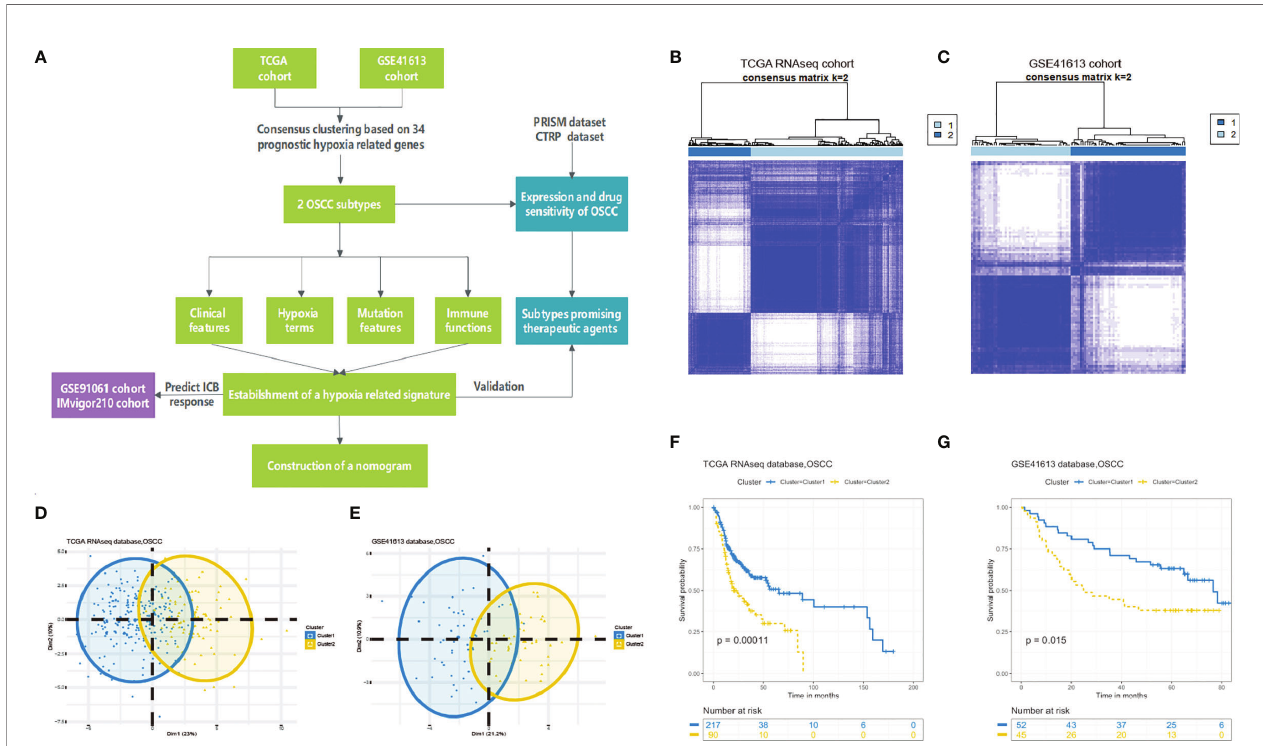
FIGURE 1 | Identi fi cation of hypoxia-related clusters in oral squamous cell carcinoma (OSCC). (A) Overview of the analysis procedures. (B, C) Unsupervised clustering of OSCC patients based on the hypoxia-associated genes generated two clusters in the TCGA and GSE41613 cohorts. (D, E) Principal component analysis based on hypoxia genes distinguished two identi fi ed subtypes in different cohorts. (F, G) Kaplan – Meier survival analysis of overall survival between the two clusters in the two